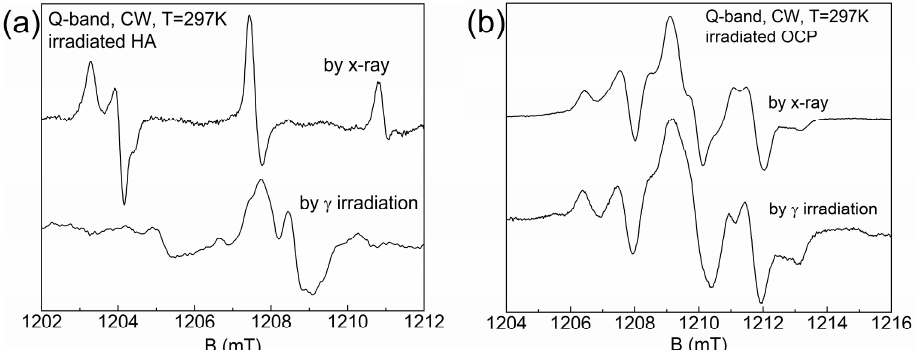
Figure 2. EPR spectra of the nitrate radical in ( a ) HA and ( b ) OCP in the Q-band frequency range at room temperature.